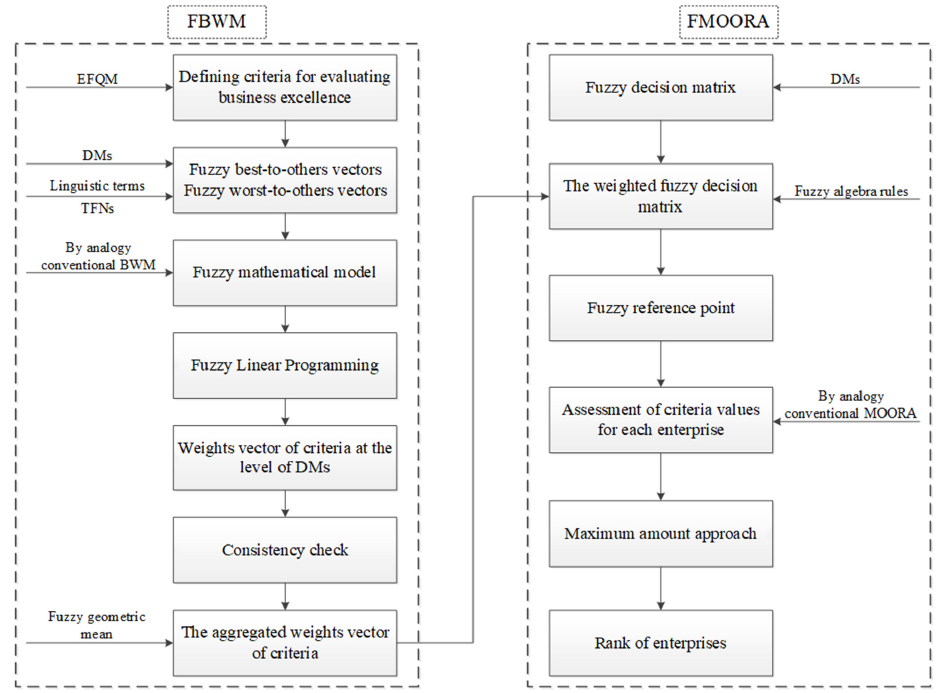
Figure 1. The proposed model for business excellence evaluation.